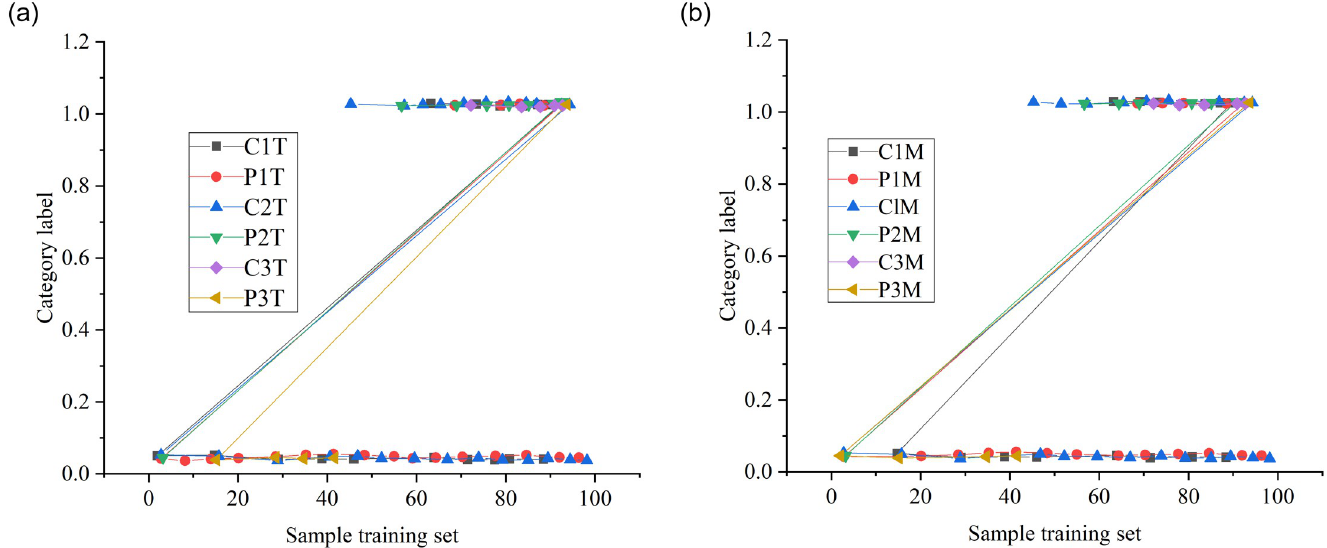
Fig 8. Experimental results of BP-GA model (on a training process). ((a) BP-GA model training sample set to predict classification results (b) Classification results of BP-GA model test sample set).